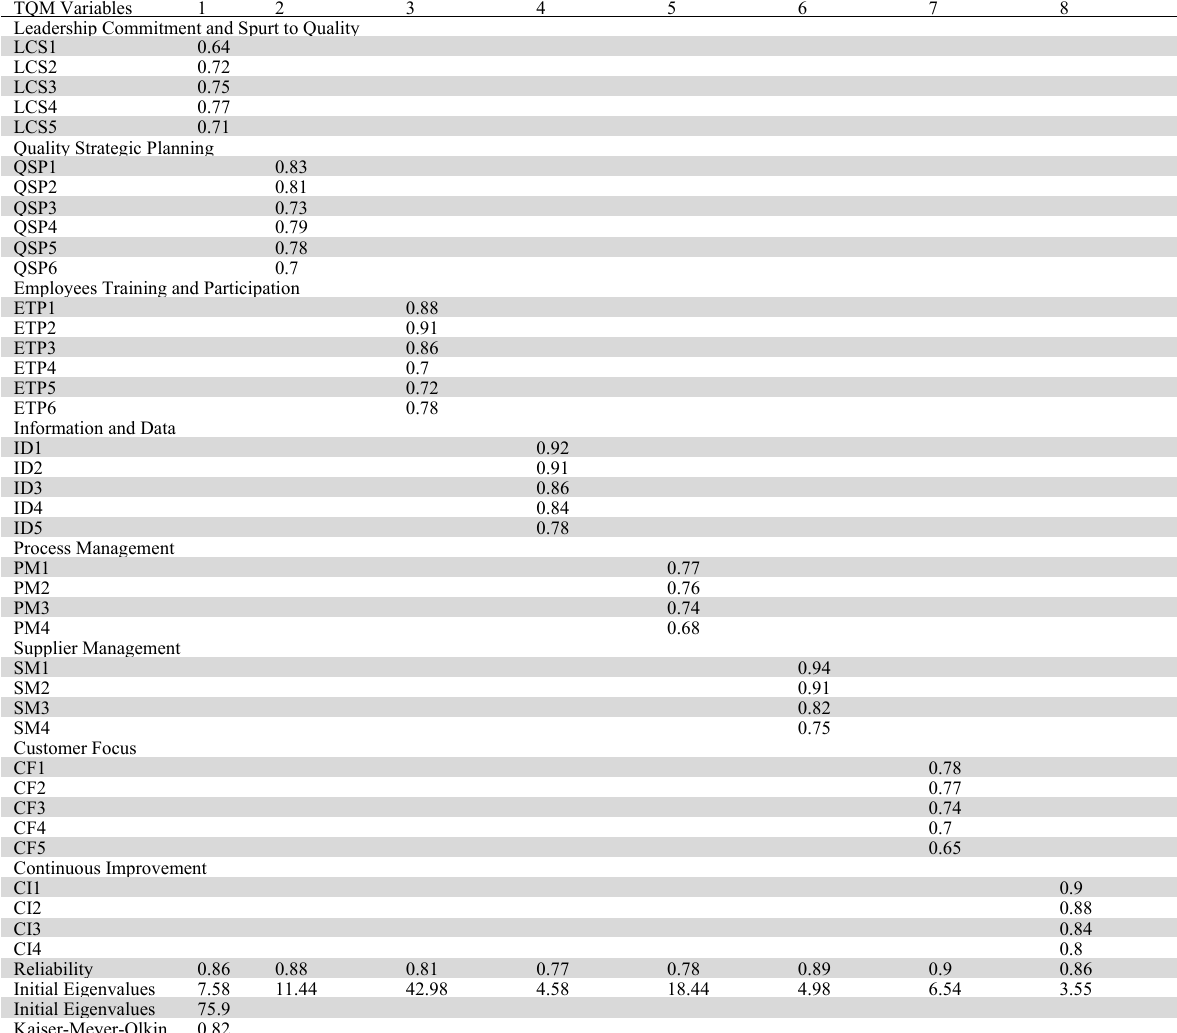
Factor Analysis on Quality